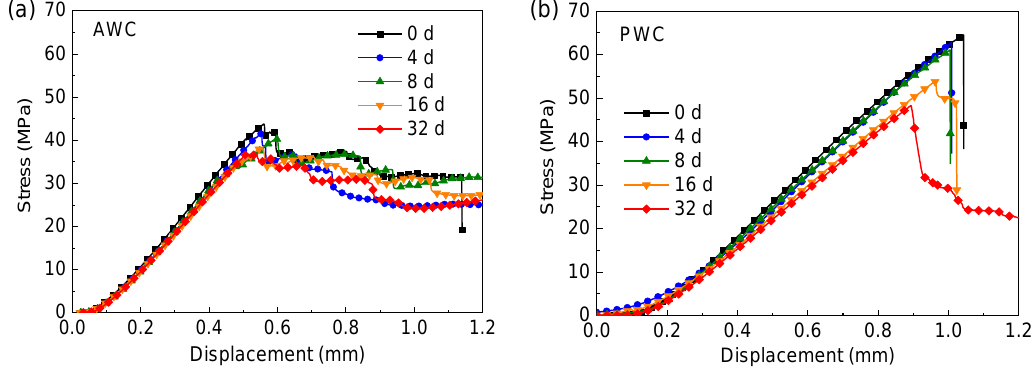
Figure 15. Load – displacement curves under the interlaminar shear tests: ( a ) AWC; ( b ) PWC.